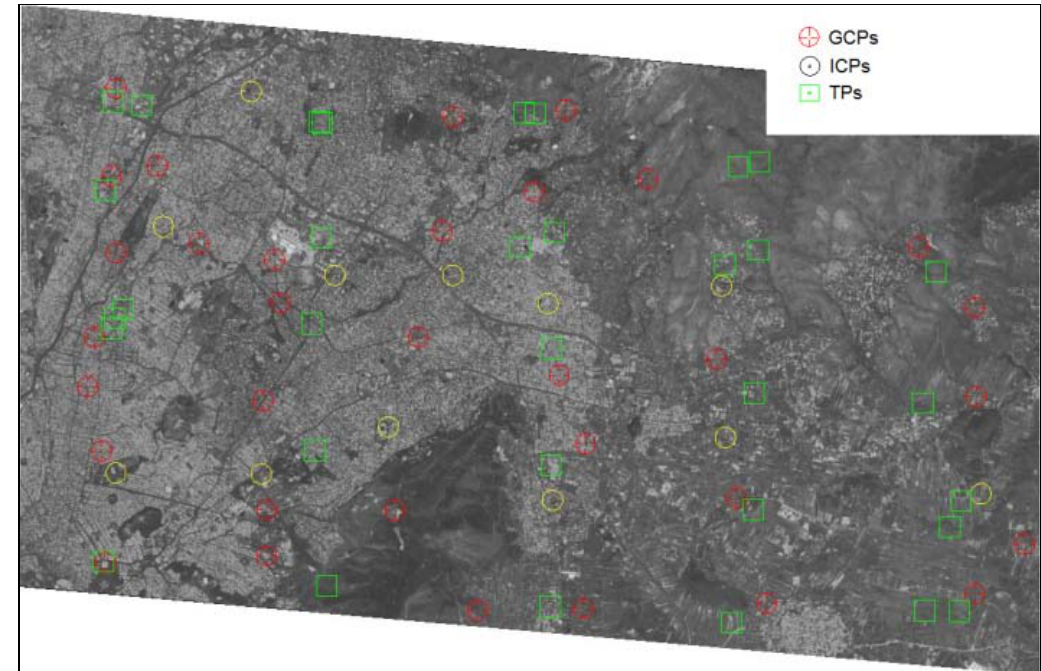
Figure 3. Distribution of 33 GCPs, 12 ICPs and 33 tie points